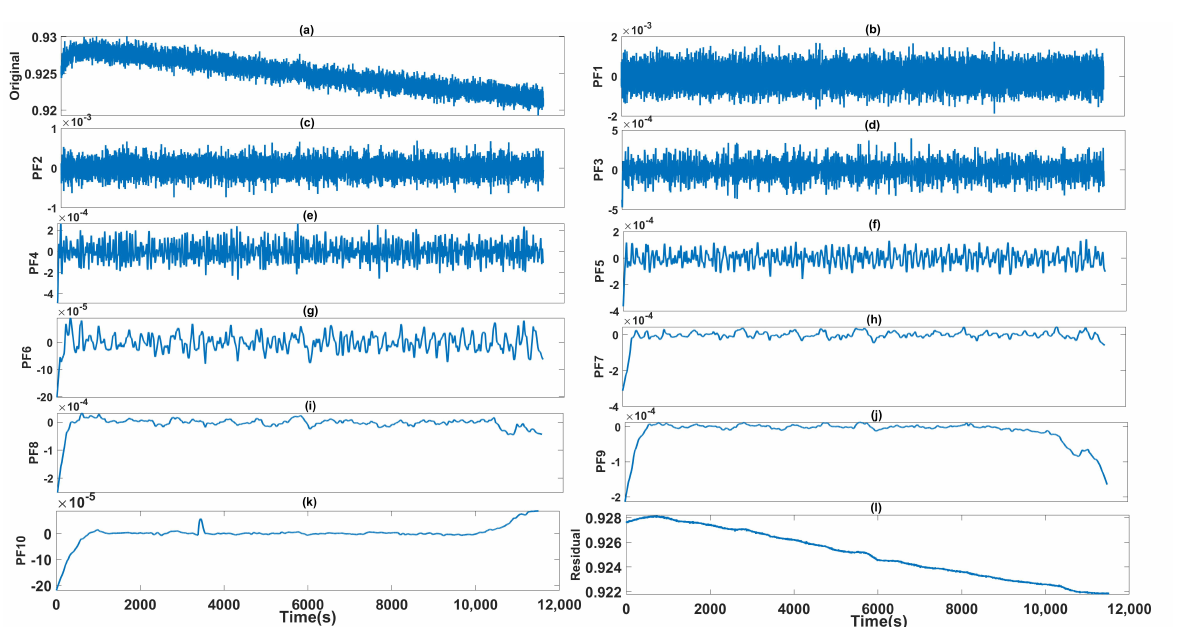
Figure 6. ( b − k ) are 10 PFs obtained by ICELMD, ( a ) is original signal and ( l ) is the residual